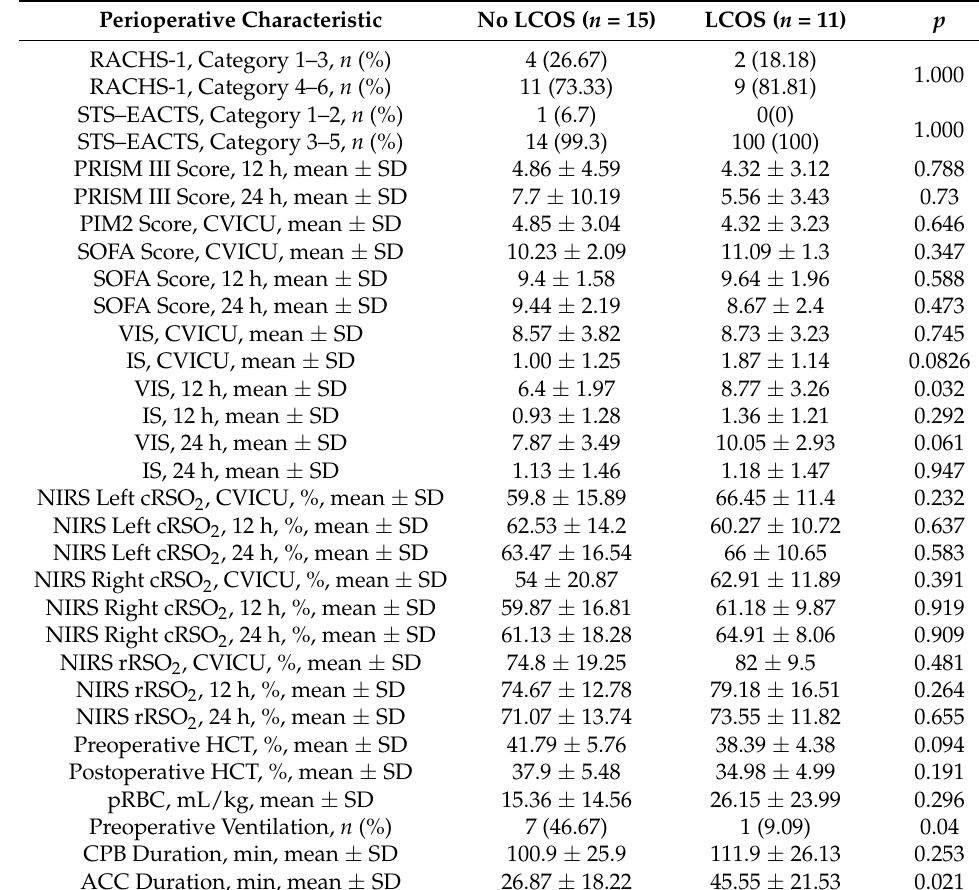
LCOS = low cardiac output syndrome, RACHS-1 = Risk Adjustment for Congenital Heart Surgery, STS- EACTS = the Society of Thoracic Surgeons and European Association for Cardiothoracic Surgery, PRISM = Pedi- atric Risk of Mortality, SD = standard deviation, PIM2 = Pediatric Index of Mortality 2, CVICU = cardiovascular intensive care unit, SOFA = Sequential Organ Failure Assessment, VIS = vasoactive-inotropic score, IS = inotropic score, NIRS = near-infrared spectroscopy, cRSO 2 = cerebral regional oxygenation, rRSO 2 = renal regional oxygena- tion, HCT = hematocrit, pRBC = packed red blood cell volume, CPB = cardiopulmonary bypass, ACC = aortic